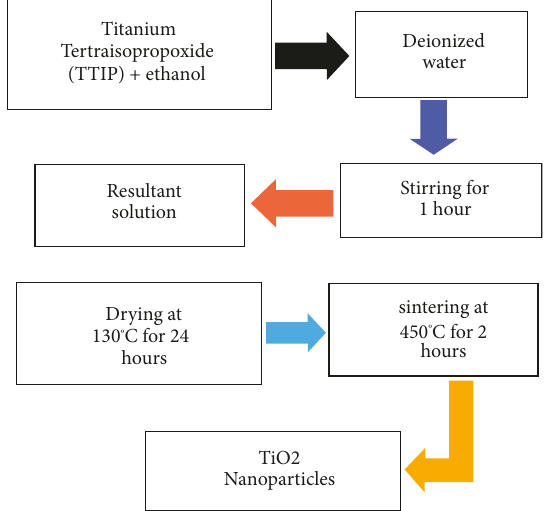
Figure 2: Preparation flowchart of TiO